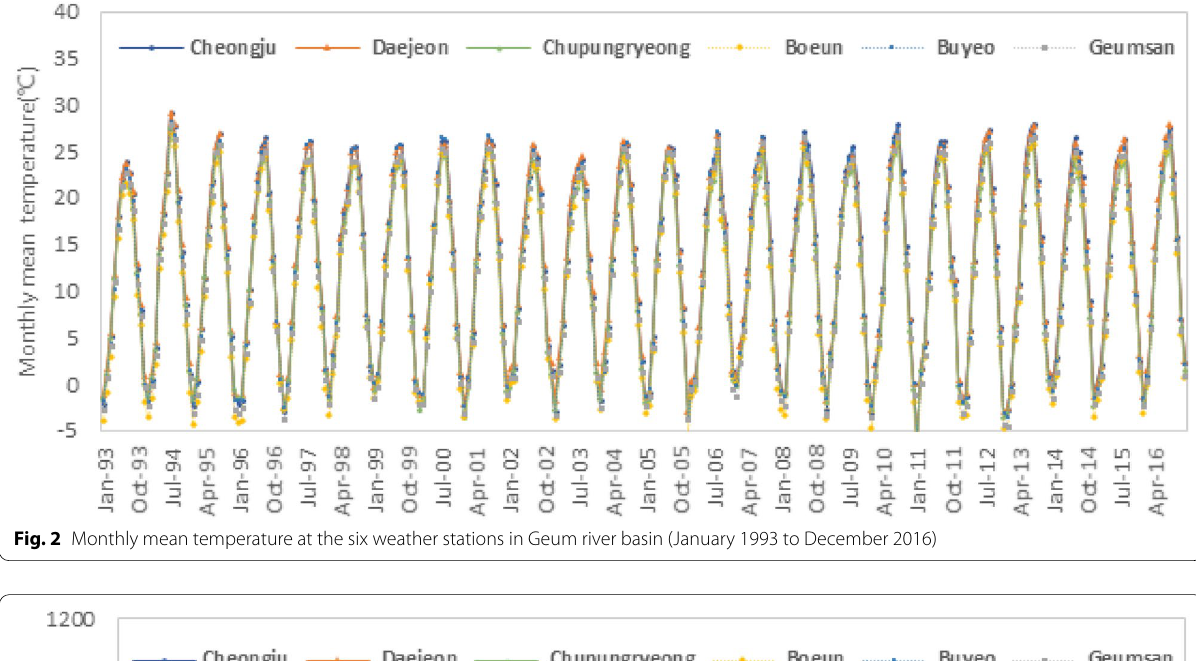
Fig. 2 Monthly mean temperature at the six weather stations in Geum river basin (January 1993 to December 2016)